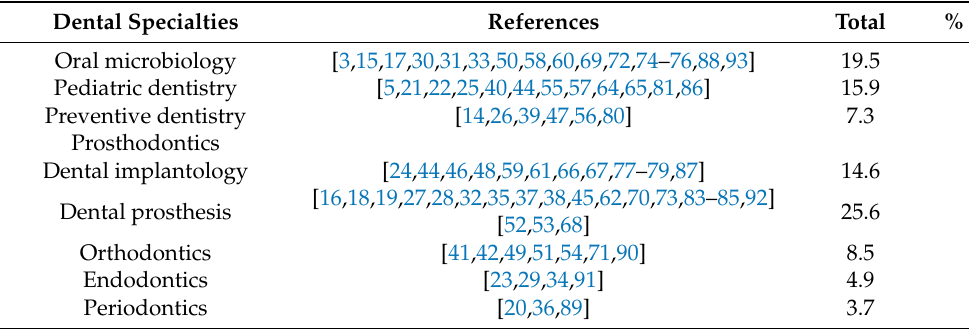
Table 3. Dental specialties and studies on silver nanoparticles. Dental